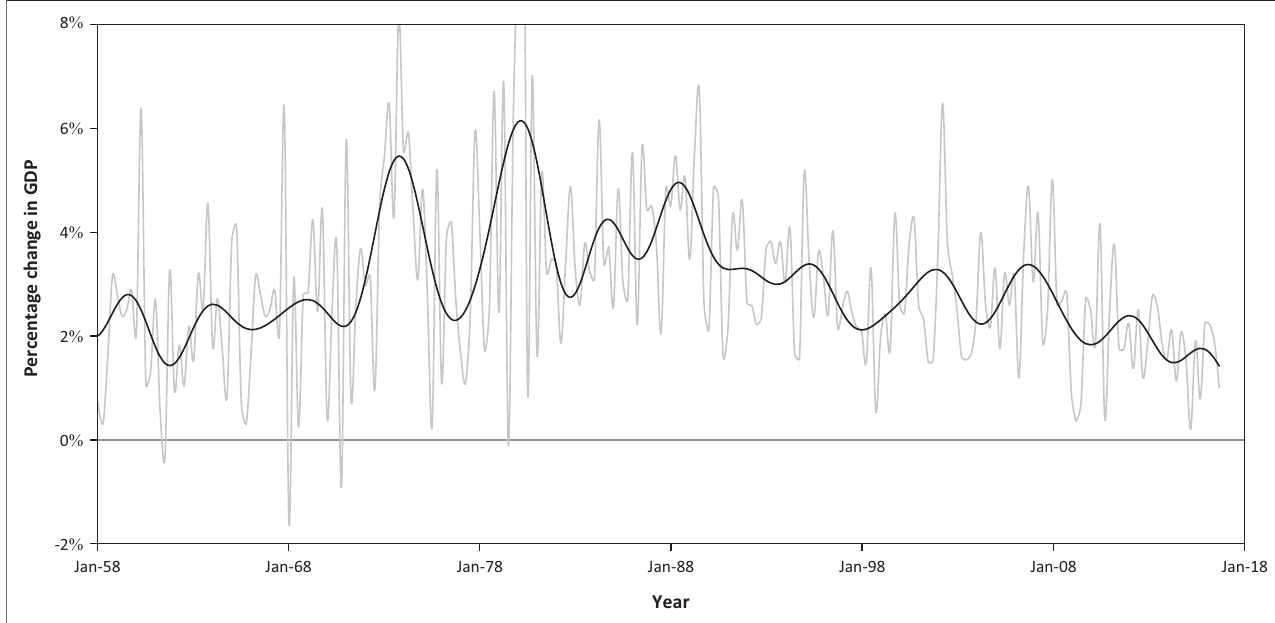
FIGURE 1: Monthly nominal percentage changes in GDP (grey line) and Fourier-fitted cycle. The most prominent cycle has a frequency of 28 quarters (7